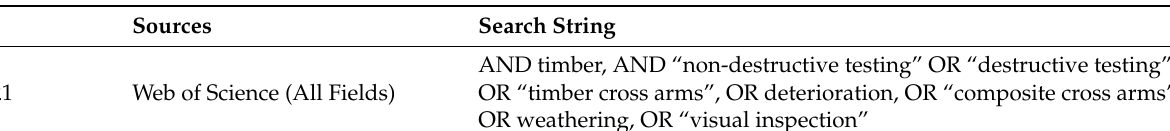
Table 1. Search string used for the bibliometric analysis.